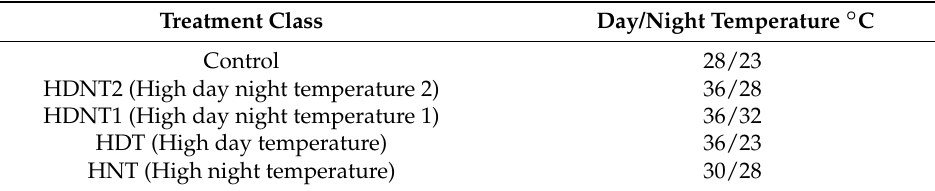
Table 5. Temperature treatments for rice seed HSI dataset.